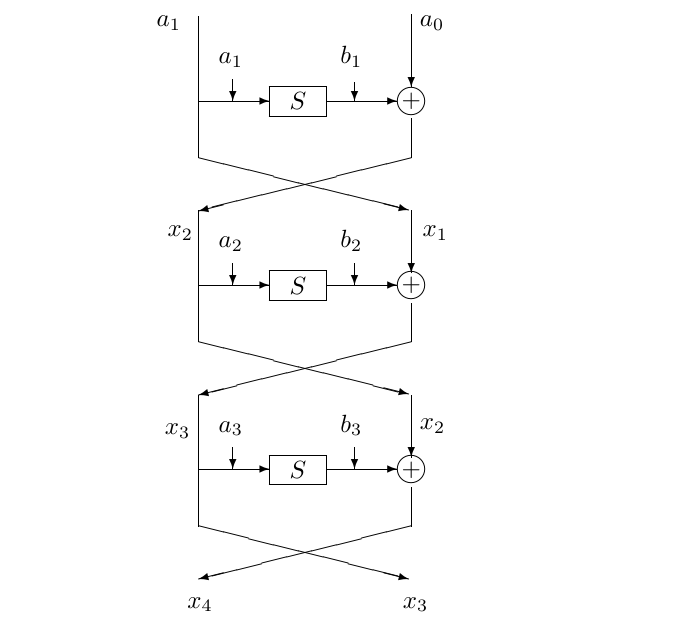
Figure 1: Differential characteristic of a three-round Feistel network where b i = a i +1 dimension of a well-defined linear space. Most notably, if S corresponds to a single S-box with differential uniformity at most 4, then